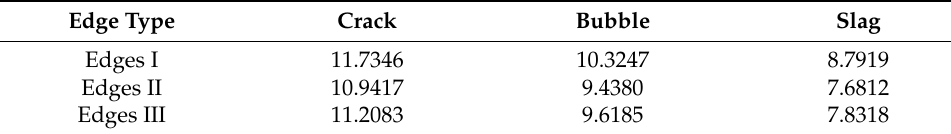
Table 1. The PSNR values of three different images with a single defect.